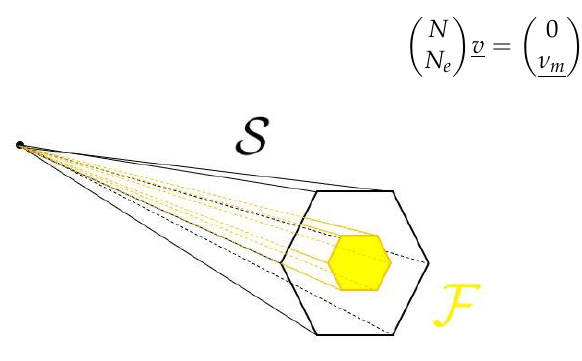
Figure 2. Cones of flux